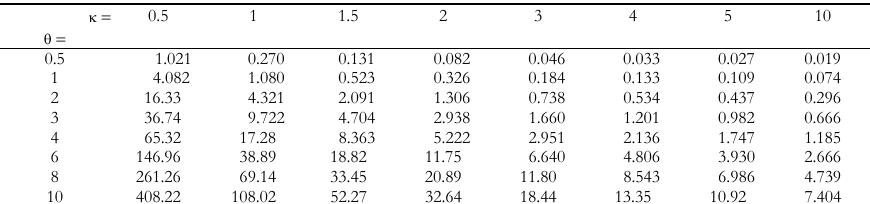
Variance of TF distribution for some parameter